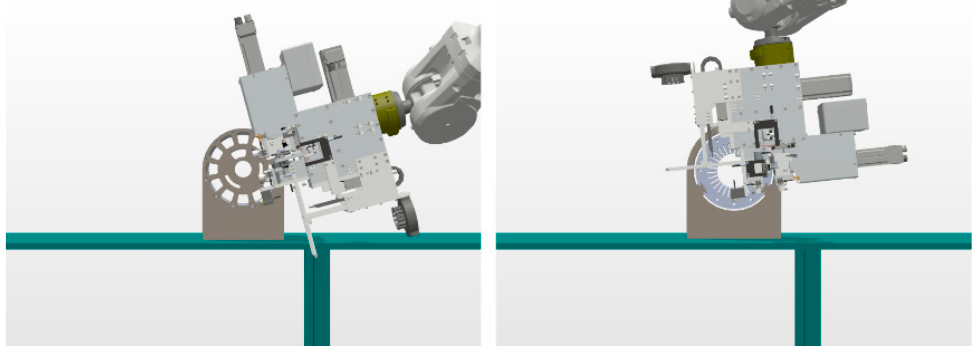
Figure 11. Robot tool positioning during winding, with the cable feeder directed radially from the outside of S2a ( left ) and vertically perpendicular from above of S2b ( right ).